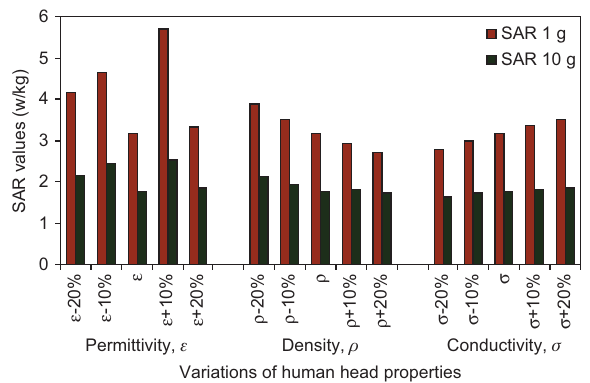
Figure 6 SAR values in human head at 1900 MHz with antenna substrate of Rogers RO3006 (loss